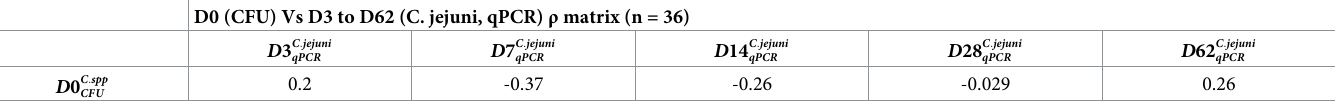
ranking order correlation was time-dependent. CFU enumeration was moderately correlated ( ρ = 0.43) to qPCR for C . jejuni at day 0 and day 14, weakly correlated (0.31 � ρ � 0.26) to day 7 and day 62 and negatively correlated at day 3 and 28, albeit none of these correlations was sta- tistically significant. Significant positive correlations were found between the ranking order of Campylobacter spp. (qPCR) and C . jejuni (qPCR) at day7 ( ρ = 0.89), day14 ( ρ = 0.89) and day62 ( ρ = 0.94) and between ranking order of total bacteria (qPCR) and C . jejuni (qPCR) at day7 ( ρ = 0.89). Although not always statistically significant when calculating the p-value spe- cific probability tables [23], a ranking order of total bacteria (qPCR) was in all cases positively correlated with the ranking of the rest of the qPCR analyses (0.37 � ρ � 0.94). Due to I) the observed drop in Campylobacter spp. concentration retrieved via CFU enu- meration, II) the similarities between CFU figures and C . jejuni concentration (qPCR), and III) the lack of ρ correlation between D0 and the rest of the time points within CFU-retrieved concentrations, D0 CFU ranking was compared to D3-D62 ranking calculated for C . jejuni (qPCR). It was found that D 0 C : spp was weakly correlated to D 3 C : jejuni and D 62 C : jejuni (average qPCR qPCR CFU ρ ~0.23) or negatively weakly correlated to the rest of the time-point rankings (average ρ ~0.22), as shown in Table 7. Table 7. Spearman’s rank-order correlation coefficient ( ρ ) calculated comparing ranking of population distribution at D0 for C. spp (CFU) and D3 to D62 for C . jejuni